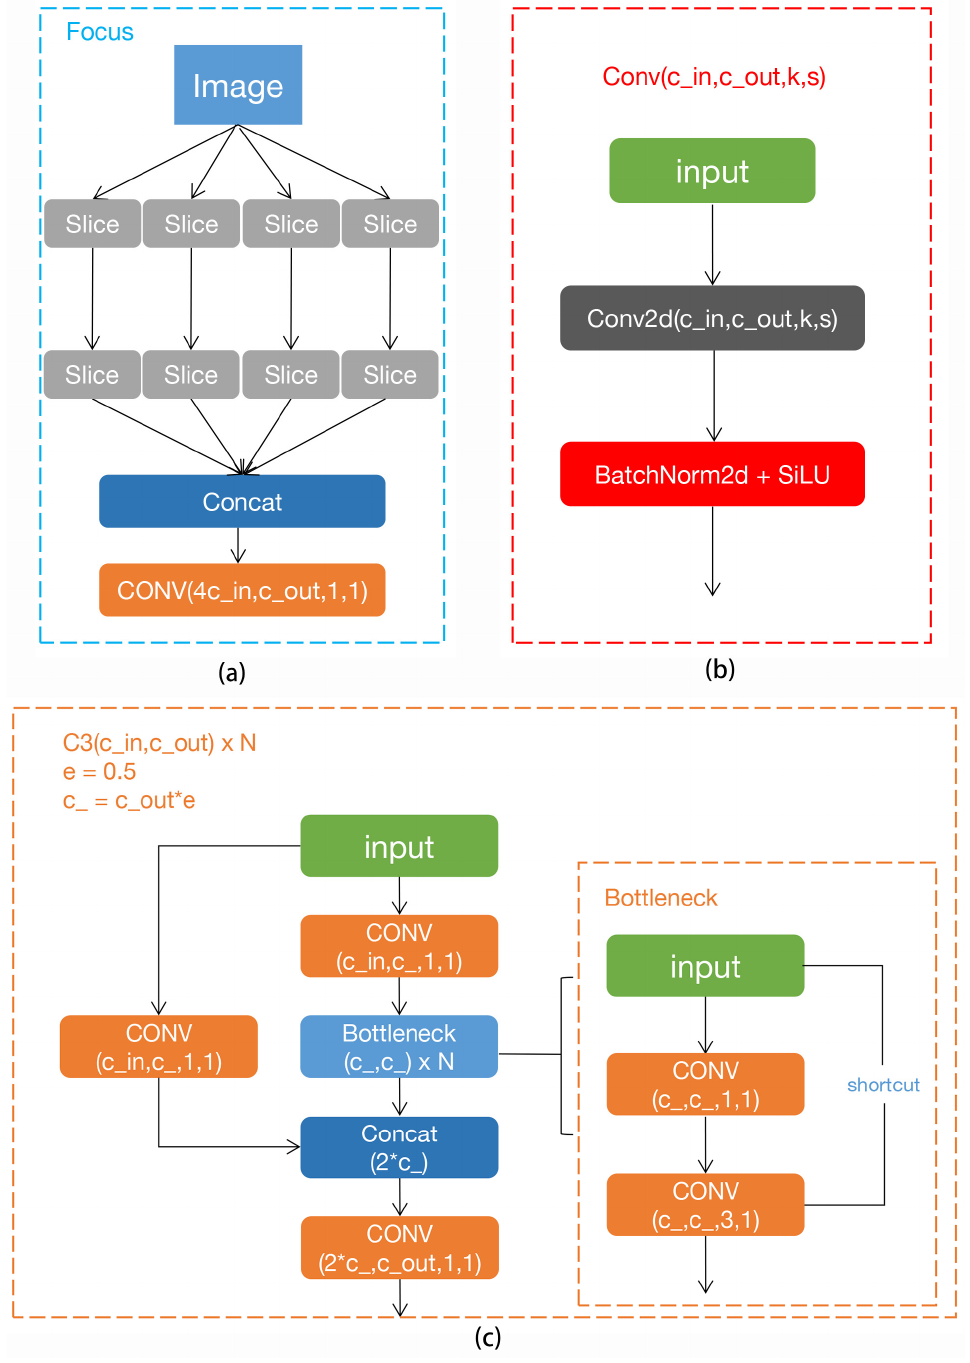
Figure 2. Partial cell structure in network mode: ( a ) structure of the Focus module; ( b ) structure of the Conv module; ( c ) structure of C3